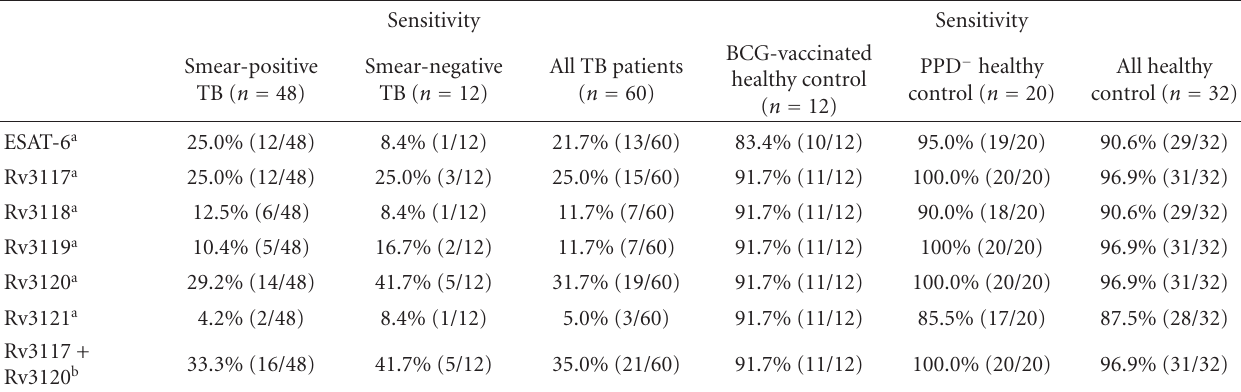
Table 2: Sensitivities and specificities for IgG antibodies against RD5-encoded M. tuberculosis